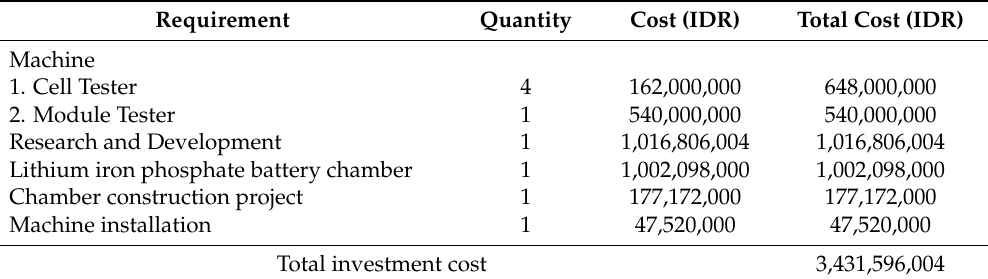
Table 5. Total Investment Cost for Lithium Iron Phosphate